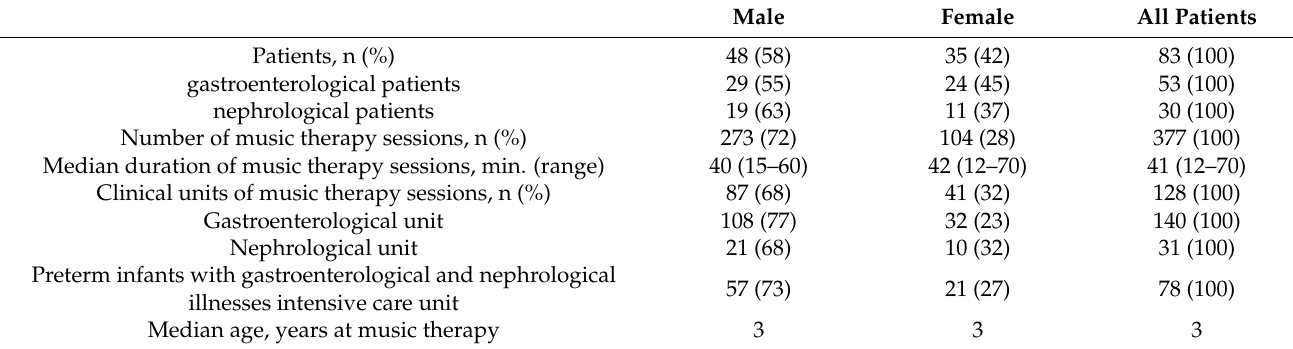
Table 1. Clinical characteristics of participants. Male Female All